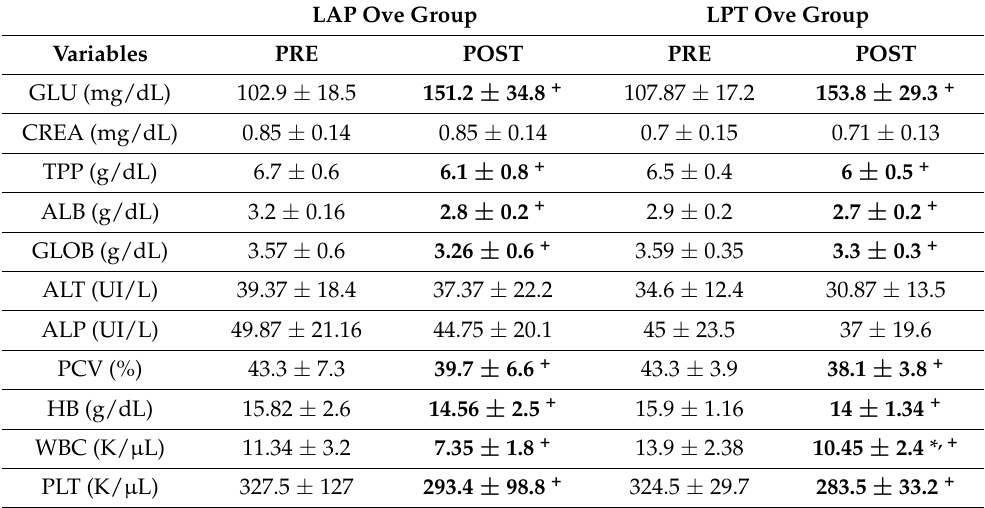
Table 2. Pre- and postoperative biochemical and hematologic